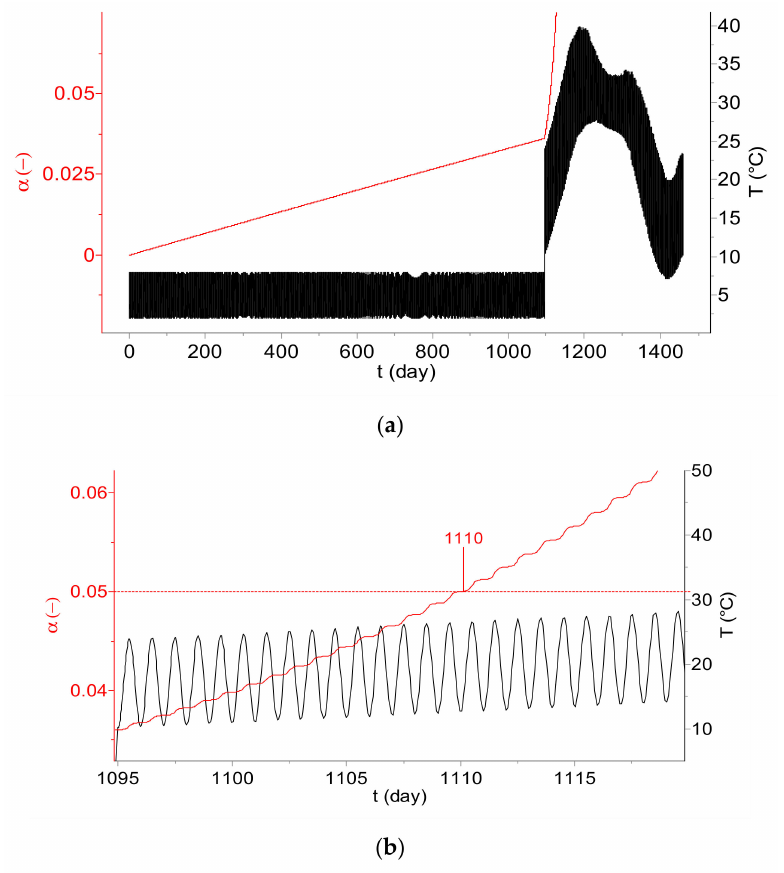
Figure 8. ( a ) Degree of the loss of infectious titer, α , after 3 years of storage in the cold chain (temperature variations between 2 and 8 ◦ C), followed by storage at a real atmospheric temperature profile corresponding to the month of March in New Delhi (India). ( b ) The storage period between 1095 and 1120 days. The shelf life is reached 15 days after removal from the cold